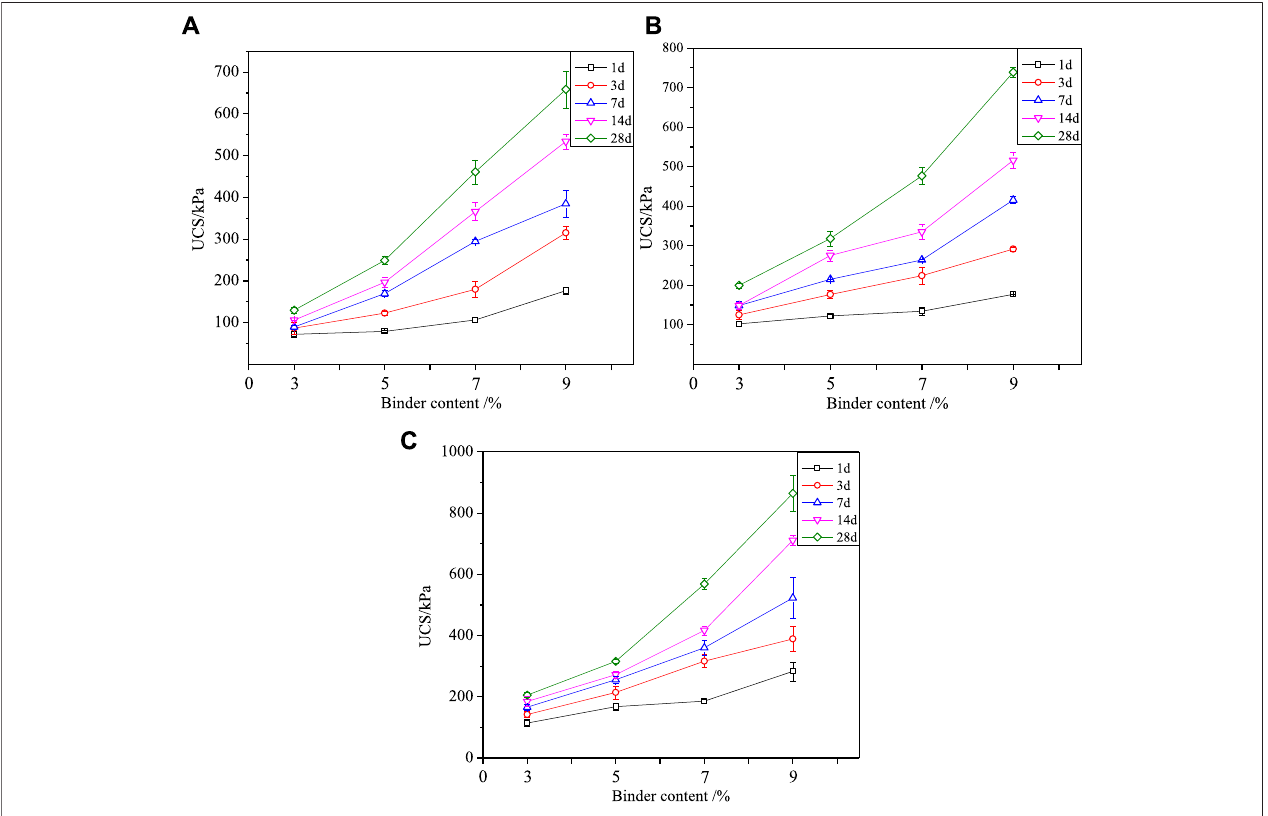
FIGURE 4 | The value of UCS corresponding to binder content under different solid content. (A) 68% solid content (B) 72% solid content (C) 76% solid content.